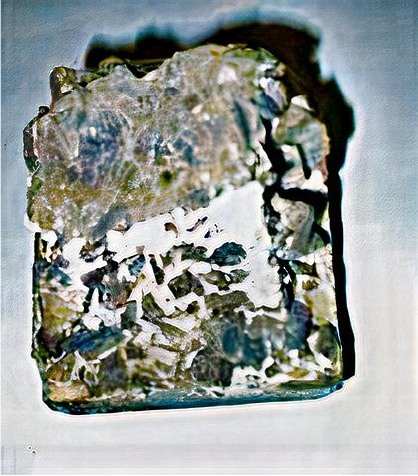
Figure 15. The cut of the sample after destruction in acid H 2 SO 4 .